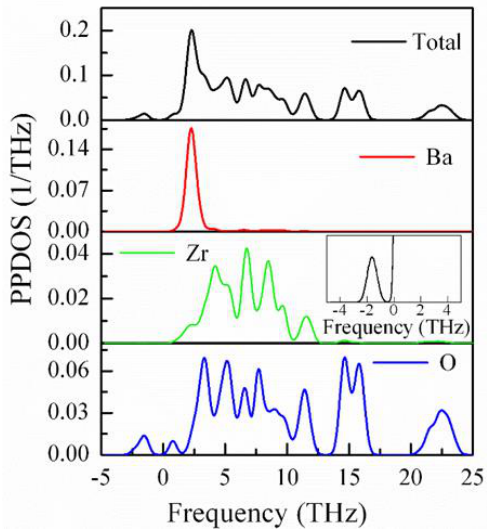
Figure 9. Partial and total phonon density of states of BZO crystals. Inset shows the contribution of Zr atom.